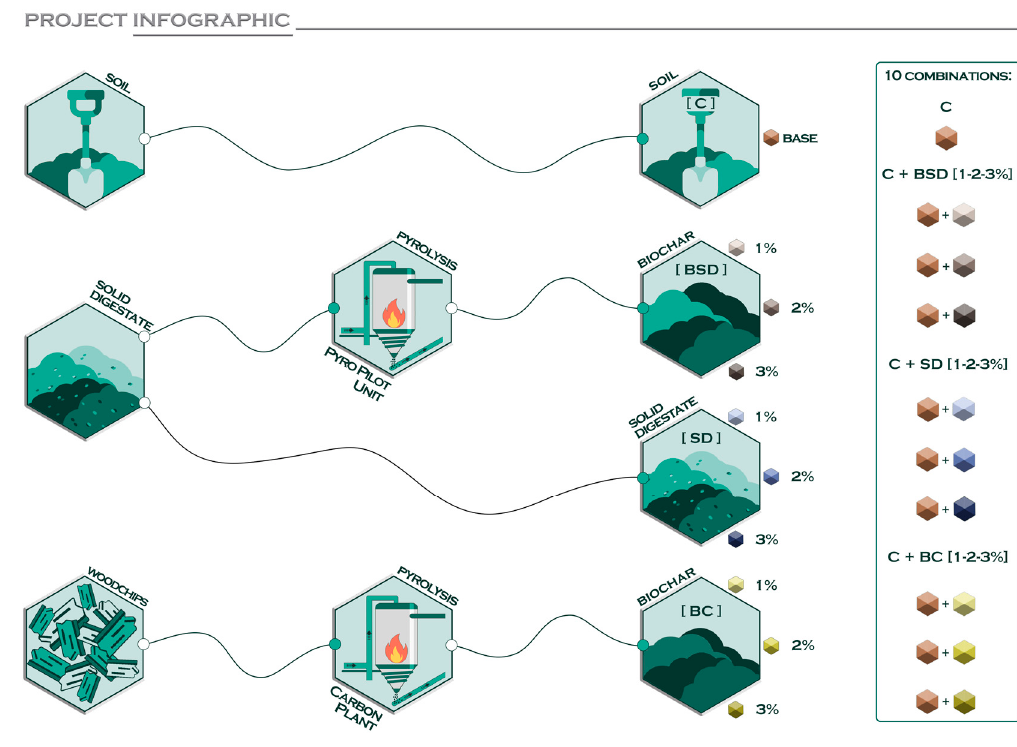
Figure 1. Experiment design.